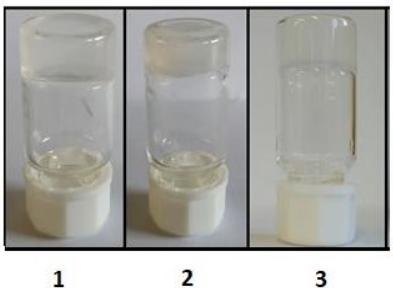
Figure 2. Optical images of hydrogels formed by dehydrodipeptides 1 – 3 . Table 1. Critical gelation concentration and pH of dehydrodipeptides 1 – 3 . Critical Gelation Concentration Peptide